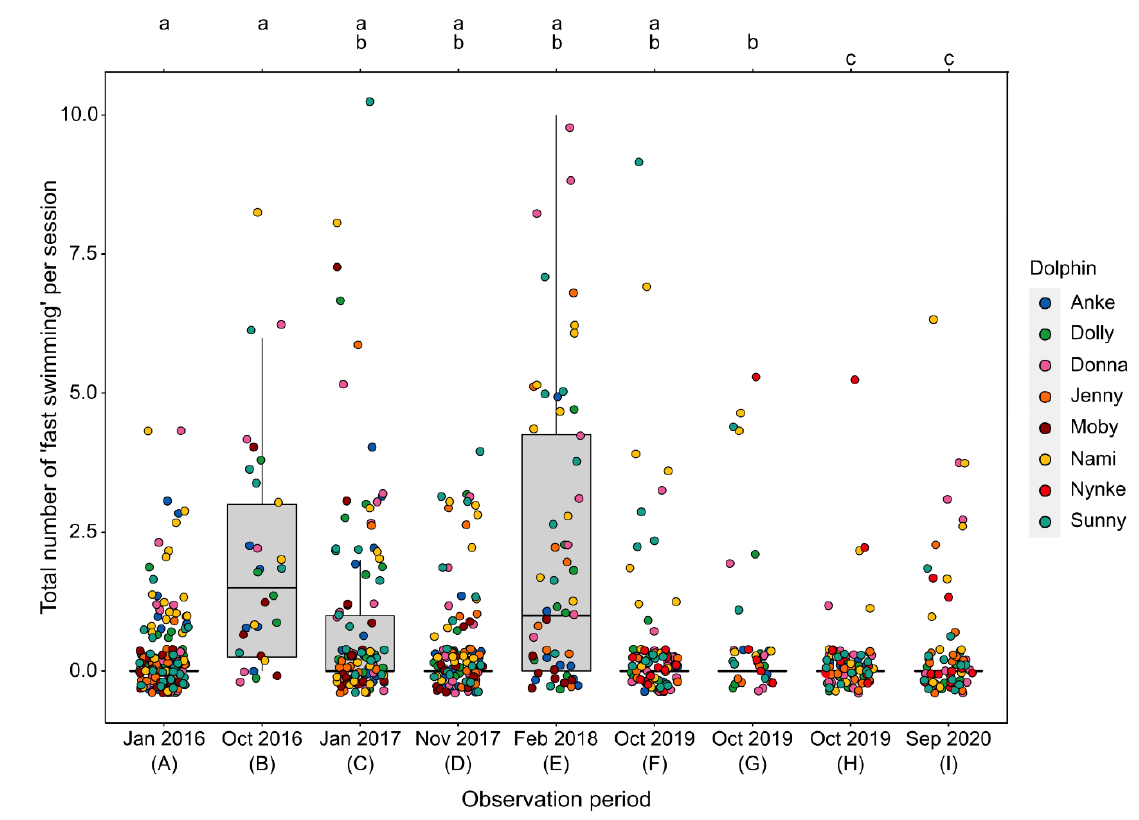
Figure 4. Frequency of fast swimming behavior for the different observation periods ( A – I ) observed for all eight focal dolphins (see Legend). Periods sharing a letter are not significantly different (based on Tukey’s post hoc test, p < 0.01).